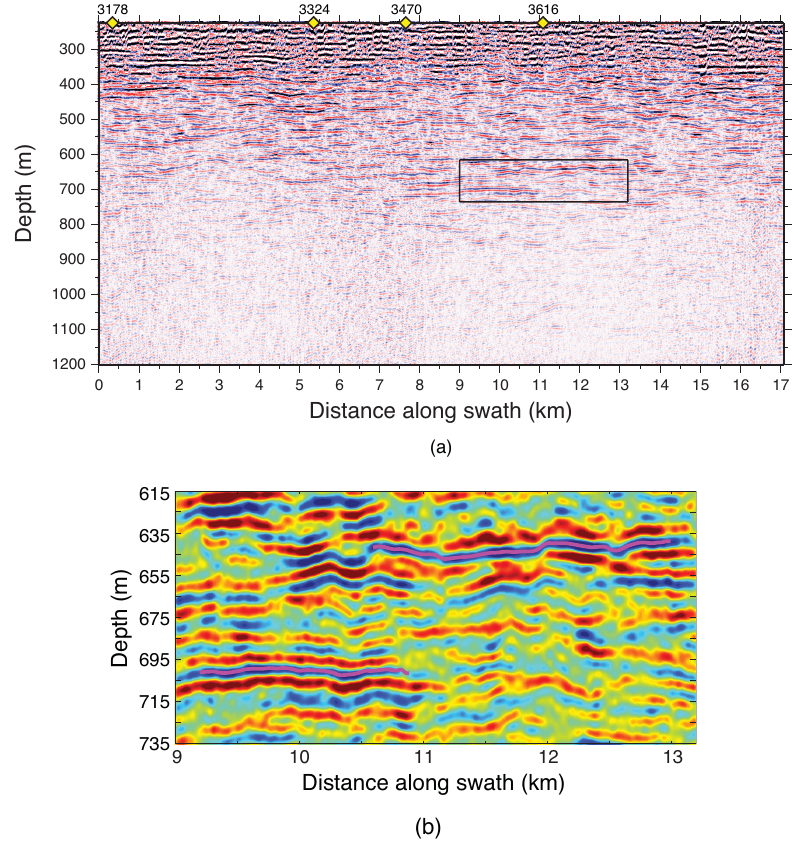
Fig. 5. (a) Migrated image of swath S170, cable 4, source 1. The images have been strongly smoothed but no relative gain control has been applied. Black box outlines region shown in (b) . Yellow diamonds at top indicate locations of XBT casts; numbers correspond to nearest shot point. (b) Selected portion of the migrated image shown in (a). Two strong continuous reflections (highlighted by pink lines) were tracked across the swath to make the reflection surfaces shown in Fig.